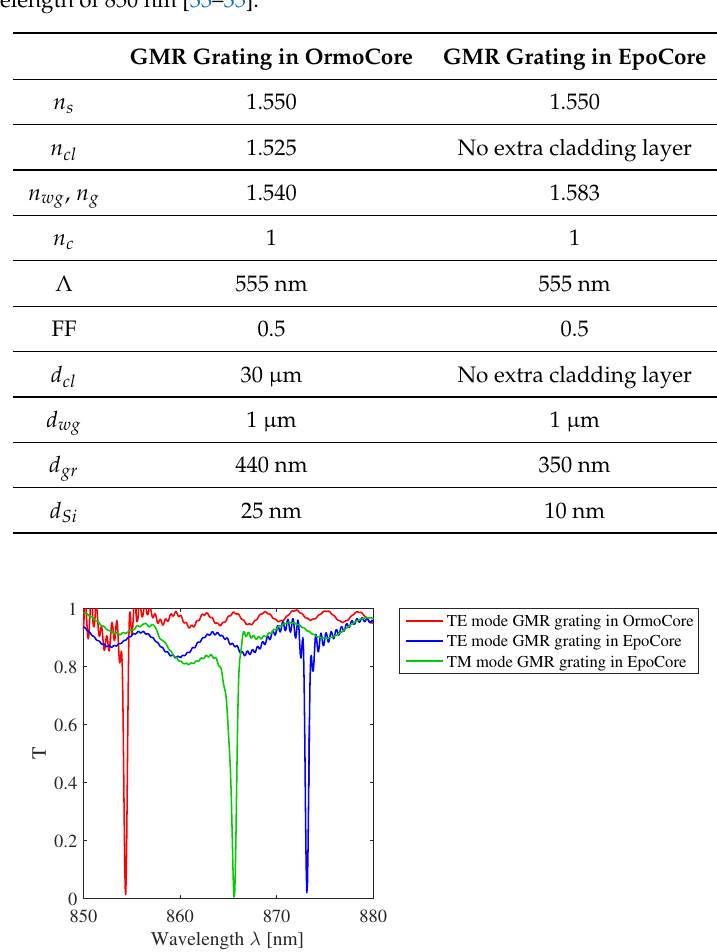
Figure 4. Simulated transmission spectra for the GMR gratings in OrmoCore and EpoCore for perpendicular incidence. The used grating parameters are listed in Table